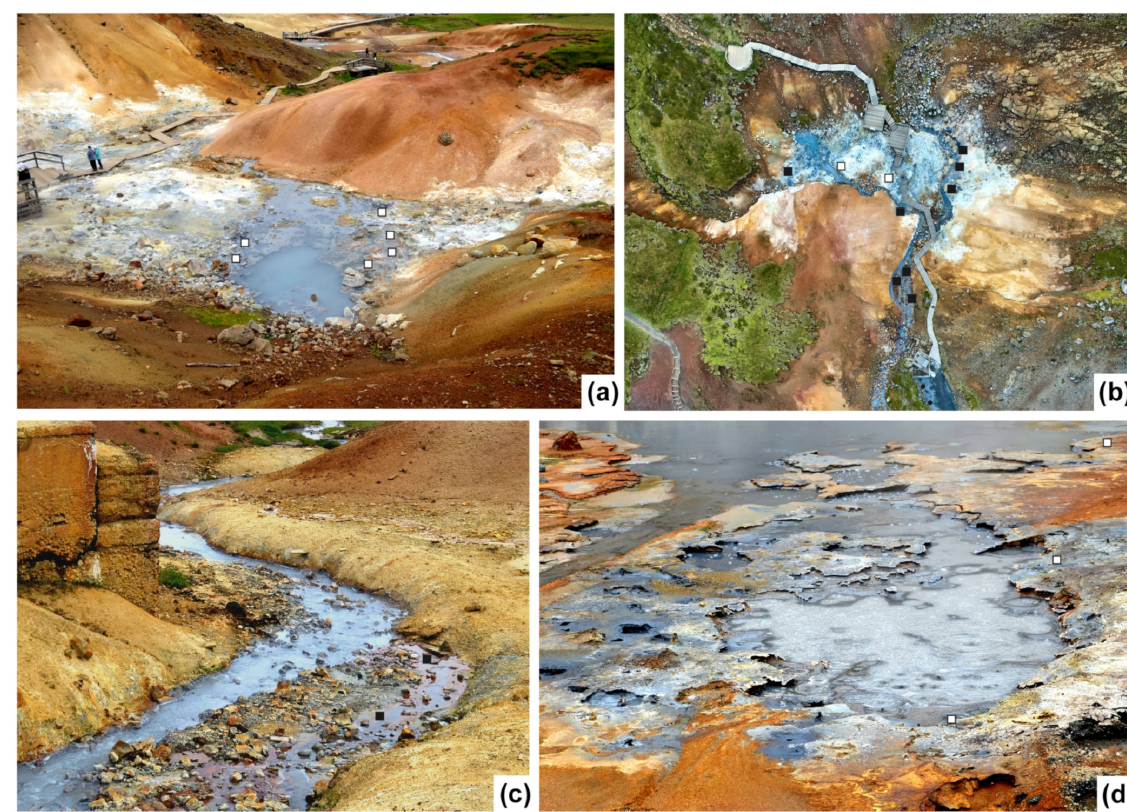
Figure 2. Field aspects of ponds and related streams at Selt ú n, Kr ý suv í k geothermal field; sampling is marked with white squares at desiccated pond margins and black squares at abandoned stream meanders. ( a ) Field view of tourist access to ponds with wooden paths (about 1.5 m wide) from the lower viewing platform. ( b ) Drone landscape photography of central pot and related streams at Selt ú n, fitted out with a wooden path for sightseeing tours; Alamy Stock Photo. ( c ) Lower terrace (about 1.2 m thick) crosscut by a meander; left scarp is about 1.6 m high. ( d ) Margin of mudpot showing orange- and gold-stained mats punctuated by emanating vapors; shelf is about 3 m